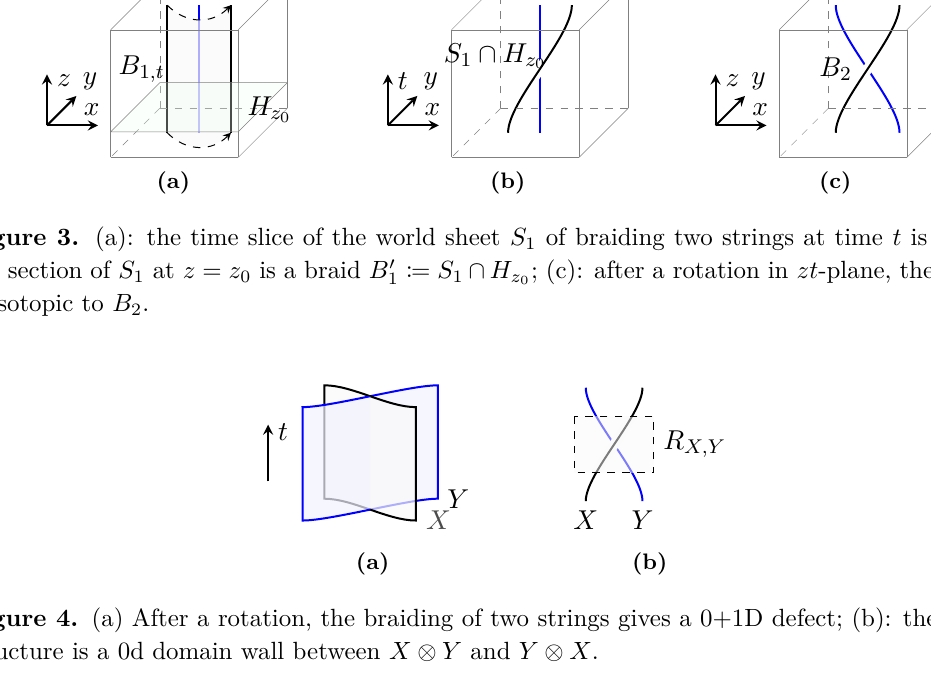
Figure 4. (a) After a rotation, the braiding of two strings gives a 0+1D defect; (b): the braiding structure is a 0d domain wall between X ⊗ Y and Y ⊗ X